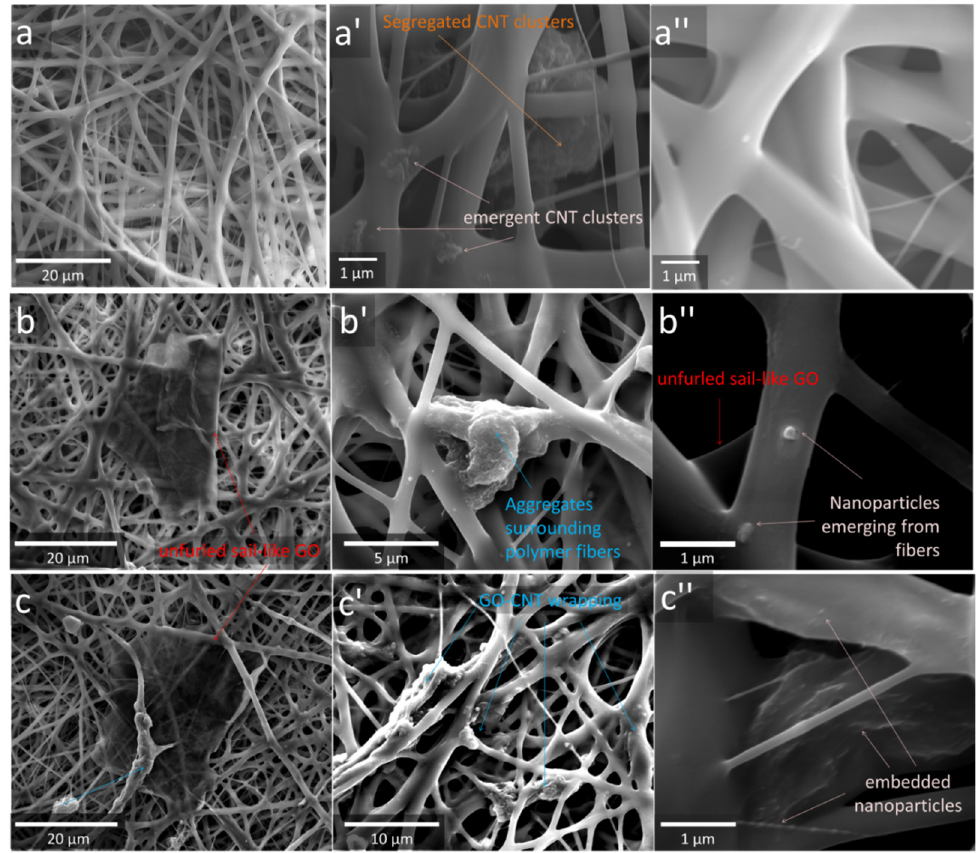
Figure 3. SEM micrographs at different magnifications of C2–G0 ( a – a” ), C2–G1 ( b – b” ), and C2–G2 ( c – c” ). Arrows indicate the peculiar morphologies imparted by